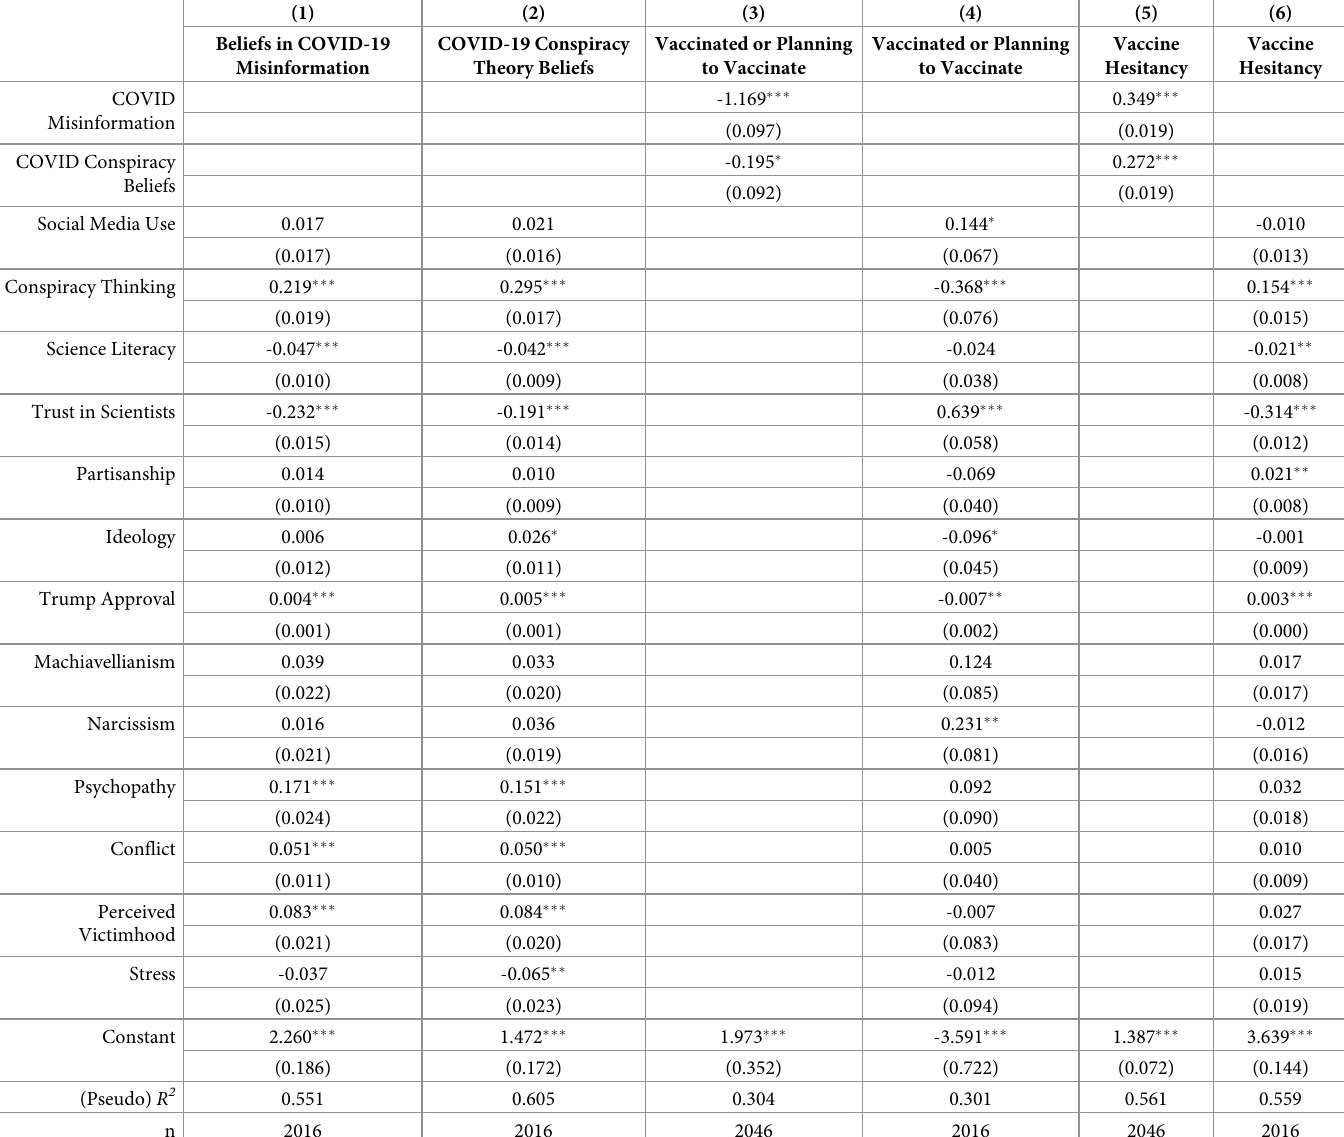
Table 3. Models of beliefs in COVID-19 CTM, vaccine hesitancy, and non-vaccination status, presented as regression coefficients with significance